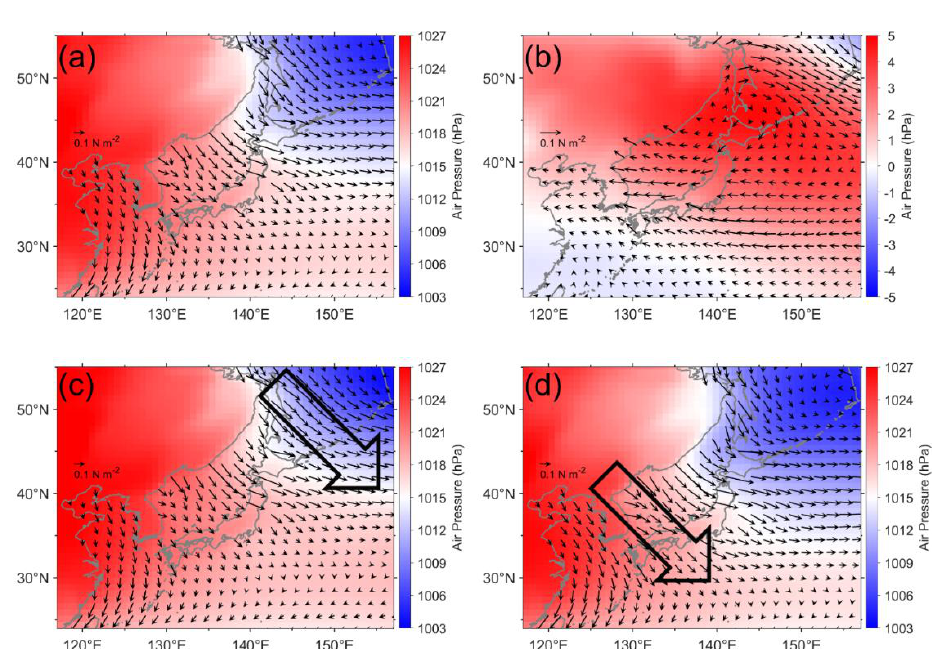
Figure 4. Composite maps of mean atmospheric pressure at sea level (hPa, colors) and wind stress ( N m −2 , small arrows) in winter ( a ) for the total period of 25 years (1993–2017) and ( b ) their differences between Periods H and L (Period H shown in ( c ) minus Period L shown in ( d )). Composite maps of mean atmospheric pressure at sea level (hPa, colors), surface wind stress ( N m −2 , small arrows), and strong northwesterly monsoonal winds exerting southeastward wind stress on the sea surface (large open arrows) in winter for ( c ) Period H and ( d ) Period L.